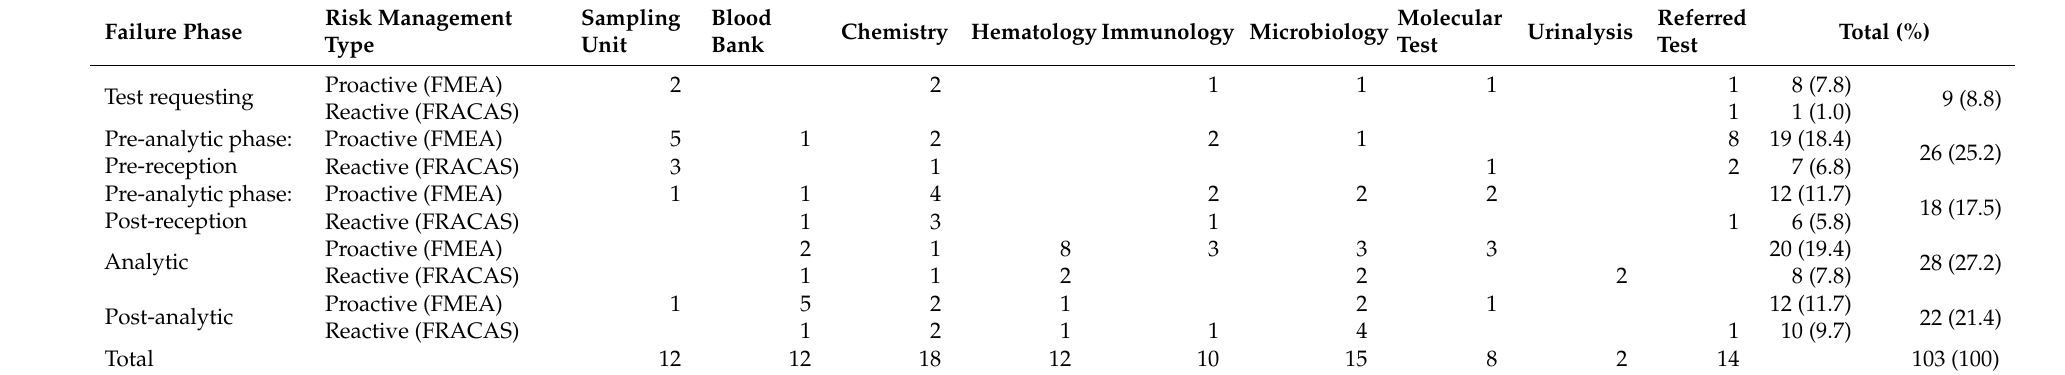
Table 2. Number of cases reported on the risk registry and management tool (RRMT) in our laboratory during one year (1 January 2020–31 December